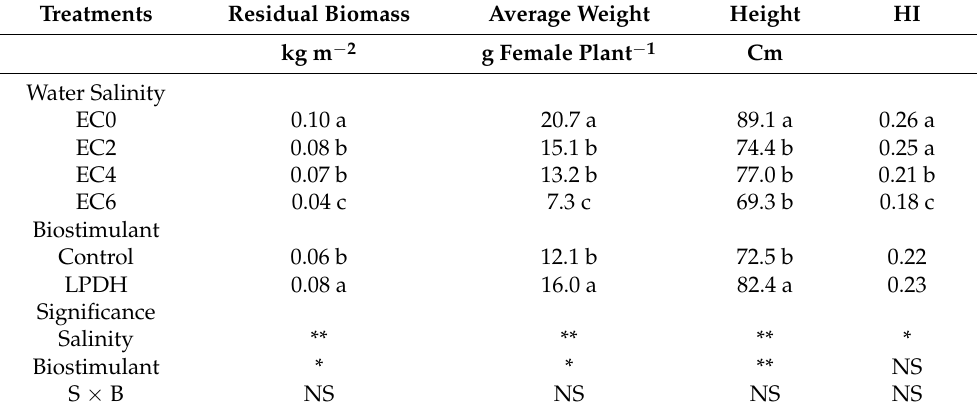
Table 3. Characteristics of hemp plants (residual biomass, plants height, average weight of female plants and harvest index) at harvest in relation to water salinity (EC0 = no-saline water; EC2 = water at 2.0 dS m − 1 ; EC4 = water at 4.0 dS m − 1 ; EC6 = water at 6.0 dS m − 1 ) and biostimulant application (treated with a commercial legume-derived protein hydrolysate (LDPH) and no-treated